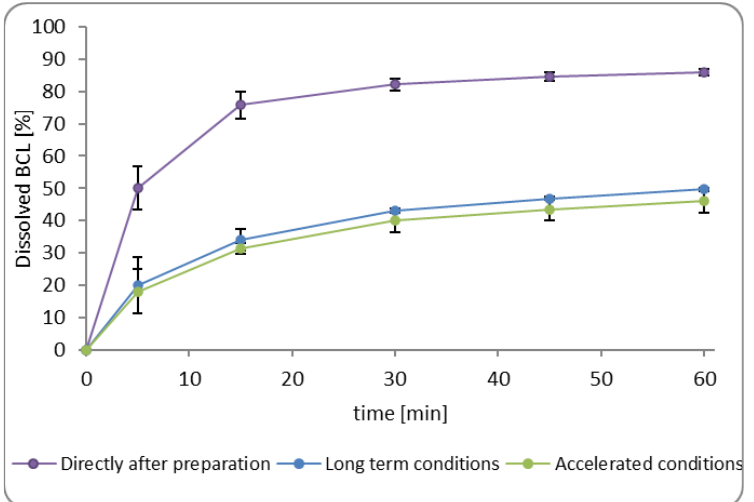
Figure 7. The dissolution profile of bicalutamide from minitablets analyzed immediately after preparation and after six months of storage in long-term (25 °C/60% RH) and accelerated (40 °C/75% RH) conditions. Minitablets were packed into PVC/Al blisters; the errors bars represent the standard deviation.